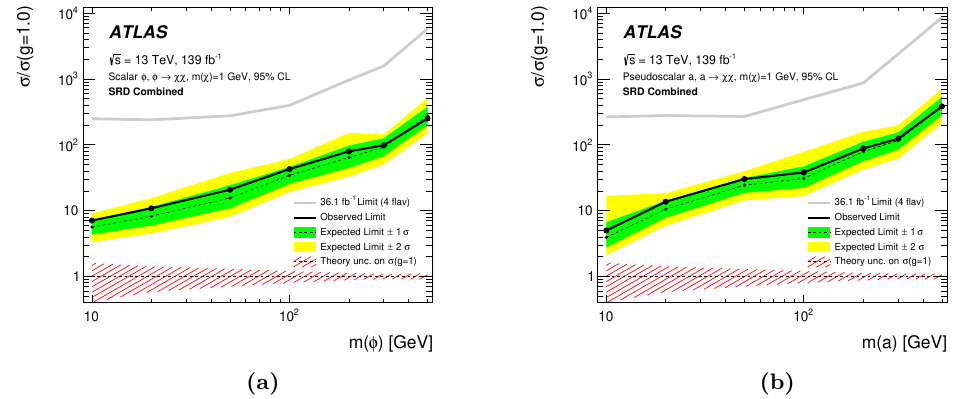
Figure 9 . Exclusion limits at 95% CL on B of LQ d pair production. The dashed line and the shaded band are the expected limit and its ± 1 σ 3 uncertainty, respectively. The thick solid line is the observed limit for the central value of the signal cross-section.